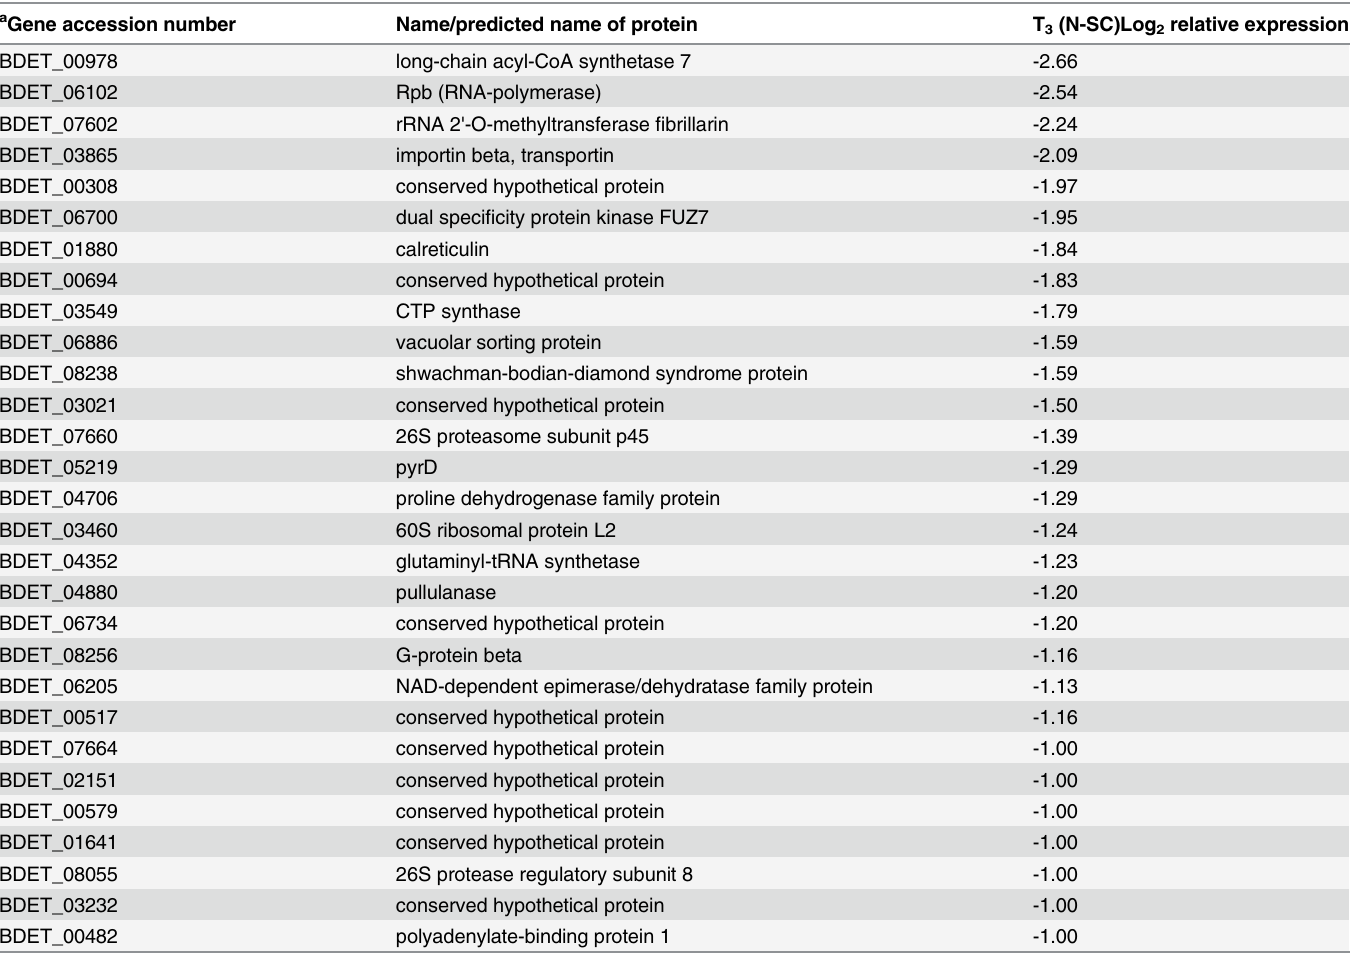
Table 3. List of proteins that showed 2-fold decrease in Bd exposed to T 3